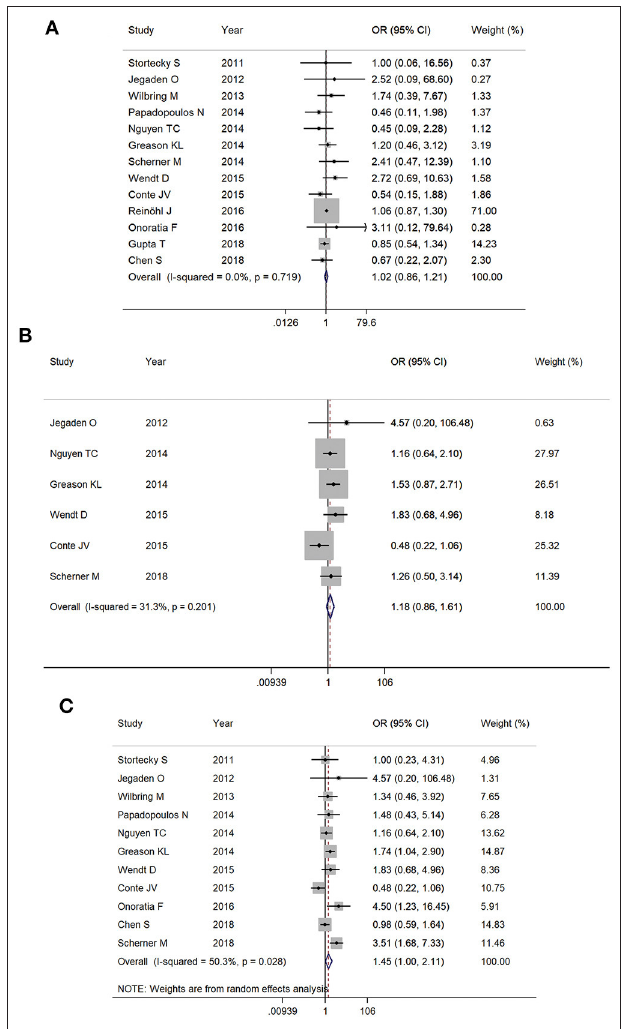
FIGURE 2 | The meta-analysis for (A) 30-day mortality, (B) 1-year mortality, and (C) overall follow-up mortality.